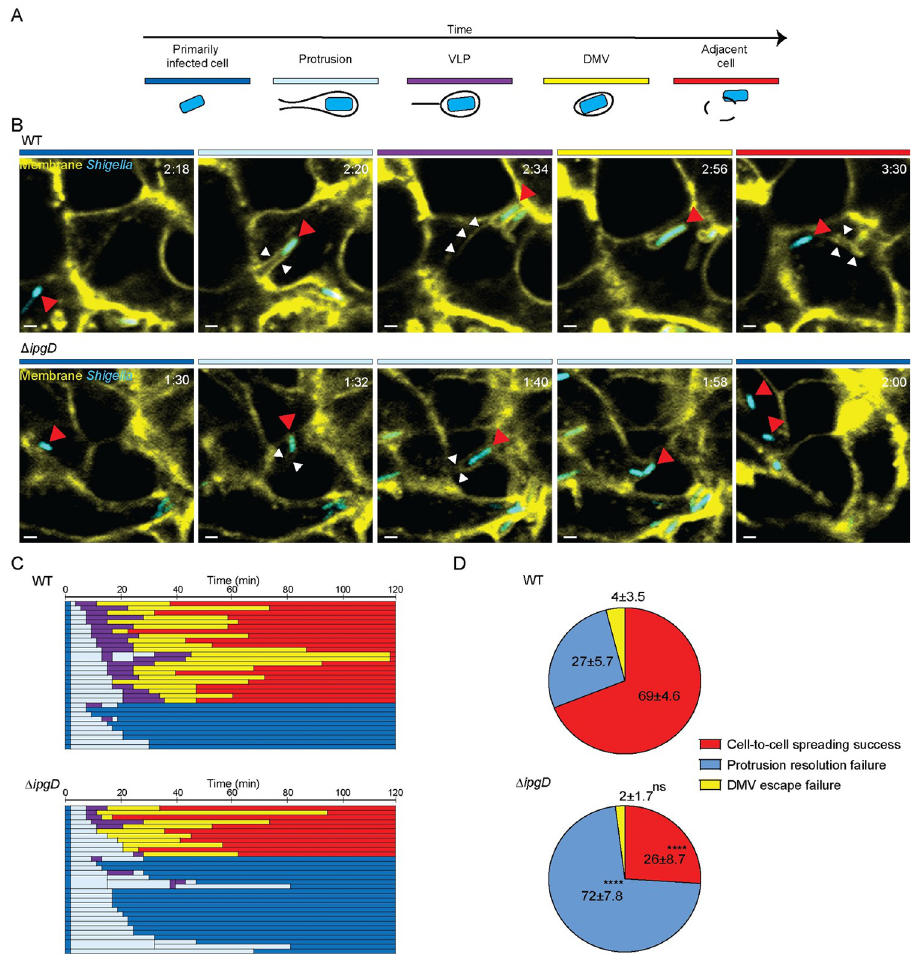
Fig 2. The Δ ipgD mutant displays defective protrusion resolution during cell-to-cell spread. (A) Schematic and color-coded representation of the compartments occupied by S . flexneri during dissemination: dark blue, primarily infected cells; light blue, protrusions; purple, vacuole-like protrusions (VLPs); yellow, double membrane vacuoles (DMVs) and red, cytosol of adjacent cells. S . flexneri is depicted in blue; the black lines represent the plasma membrane surrounding the bacteria. (B) Representative images showing successful (WT) and failed ( Δ ipgD ) cell-to-cell spread. During successful dissemination, WT pCFP strain displays the formation of canonical membrane compartments (red arrows), including protrusion (t[2:20]; white arrowheads, protrusion neck), VLP (t[2:34]; white arrowheads, membrane tether of VLP), DMV (t[2:56]) and vacuolar escape (t[3:30]; white arrowheads, DMV remnants). Upon failed dissemination due to protrusion resolution failure, Δ ipgD pCFP strain forms protrusion (t[1:32]; white arrowheads, protrusion neck) that does not transition into VLP (t[1:32–1:58]; white arrowheads, protrusion neck) ultimately collapses back to the primarily infected cell (t[2:00]). Color-coded bars above images, membrane compartment represented in Panel A; t, relative time as hour: minute; scale bar, 2 μ m. (C) Tracking data from one of the independent biological replicates ( n = 3). At least thirty bacteria were tracked in each biological replicate. The length of each bar reflects the time spent (min) in each color-coded compartment (D) Pie chart showing the proportion of WT and Δ ipgD successful cell-to-cell spread (red), protrusion resolution failure (blue), and DMV escape failure (yellow) as mean (+/- s.d.) of all biological replicates ( n = 3). Statistics: two-way ANOVA statistical analysis followed by Sidak’s multiple comparison test comparing strains; ���� P < 0.0001; NS, not